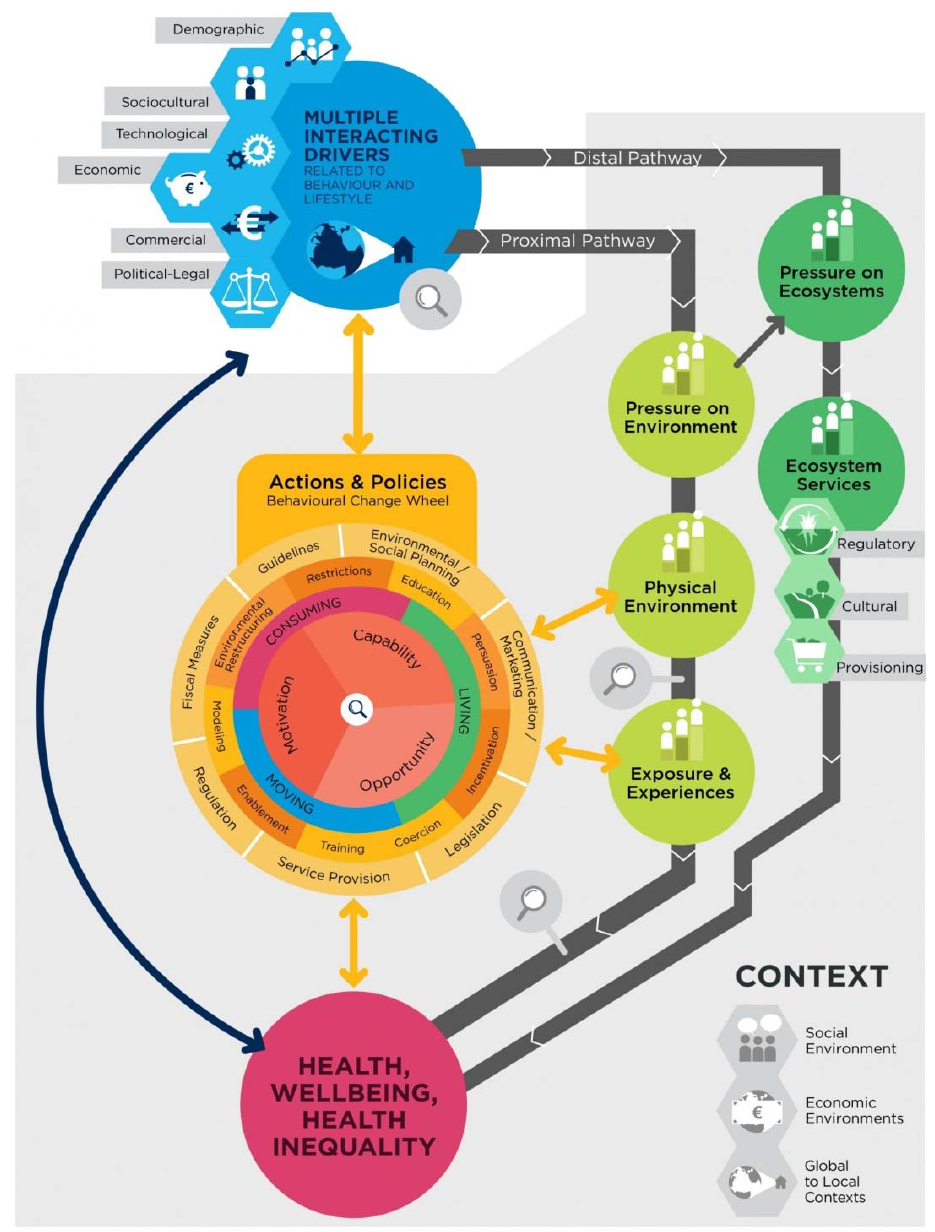
Figure 1. The INHERIT model (the INHERIT model integrates the ecologically enriched DPSEAA model (right side of the model) and Behavioural Change Wheel (left side of the model) bringing together ecological public health and behavior. In addition, icons with individuals standing on different levels throughout the pathways represent inequalities. Magnifying glasses represent spots in the model where behavior plays an important role, either interacting with drivers or modifying effects from the physical environment, exposures to this environment and health, wellbeing and health inequalities impacts.).